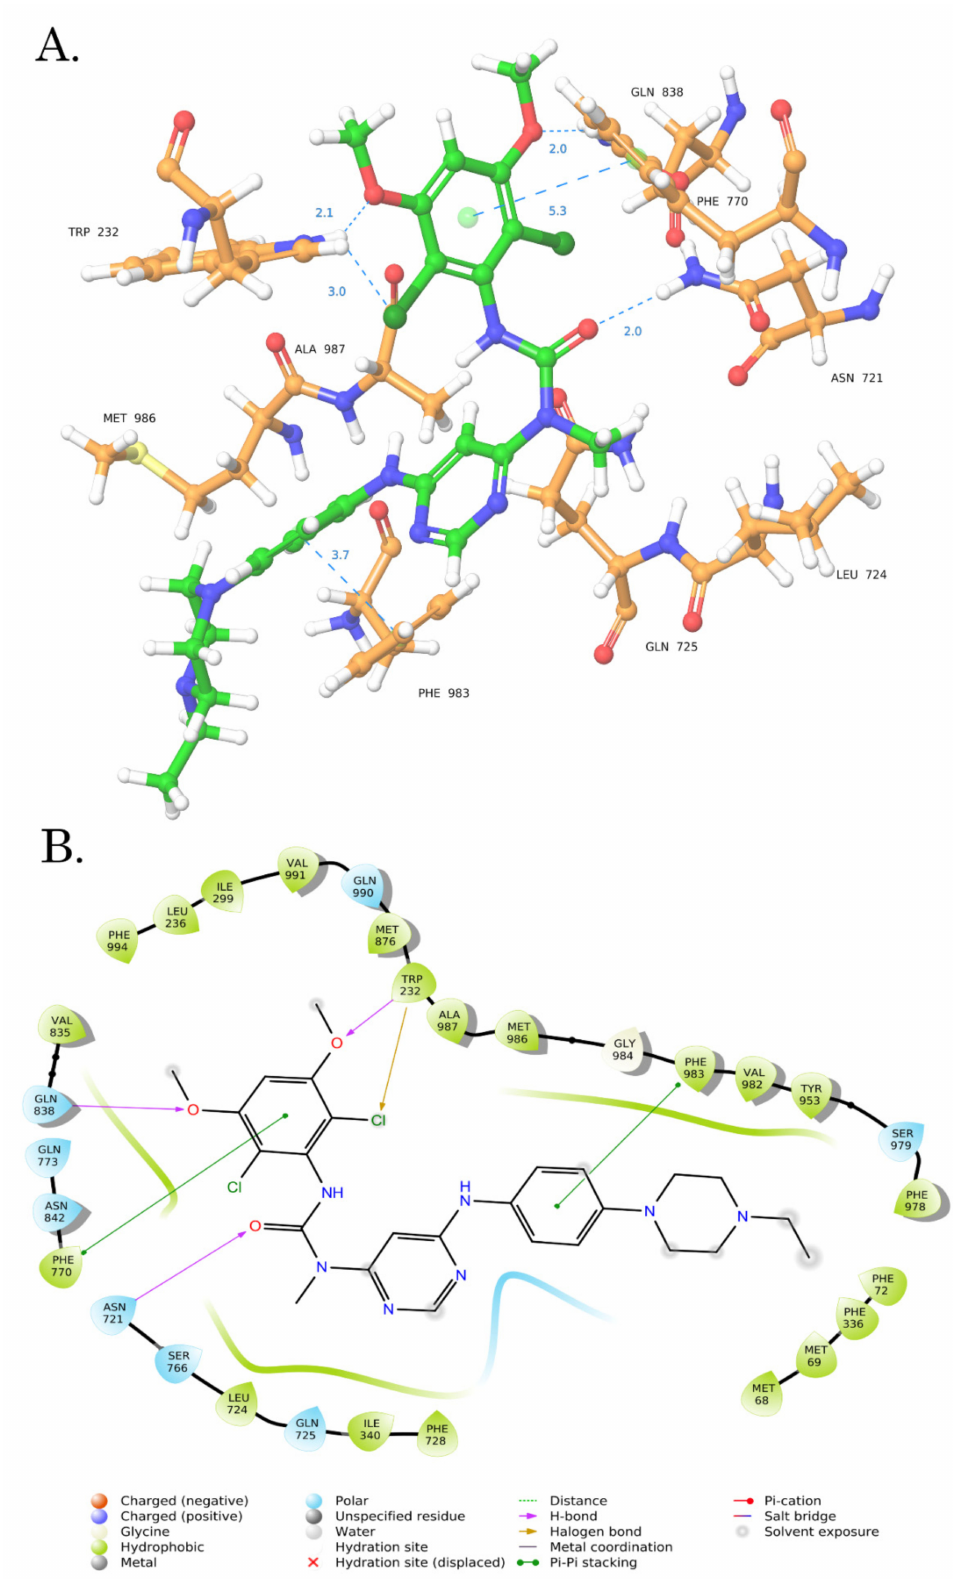
Figure 11. Computer modeling of BGJ 398 binding pose on DBP of ABCB1. ( A ) 3D diagram illustrating the proposed binding mode of the interactions of BGJ 398 with the ABCB1. ( B ) 2D Ligand interaction diagrams of the BGJ 398 with significant amino acid